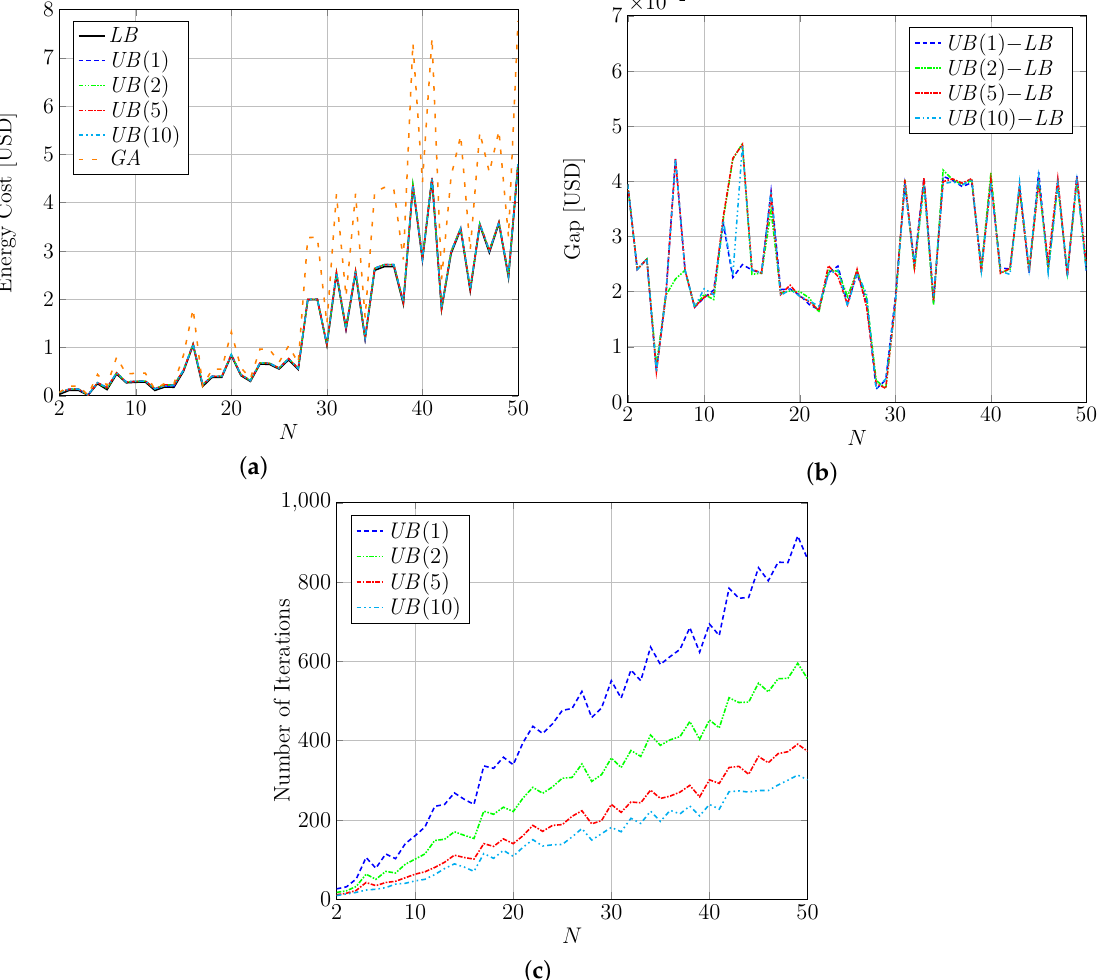
Figure 5. Atomic energy consumption scheduling for cost minimization: ( a ) Upper ( UB ) and lower bounds ( LB ); ( b ) gaps; and ( c ) number of